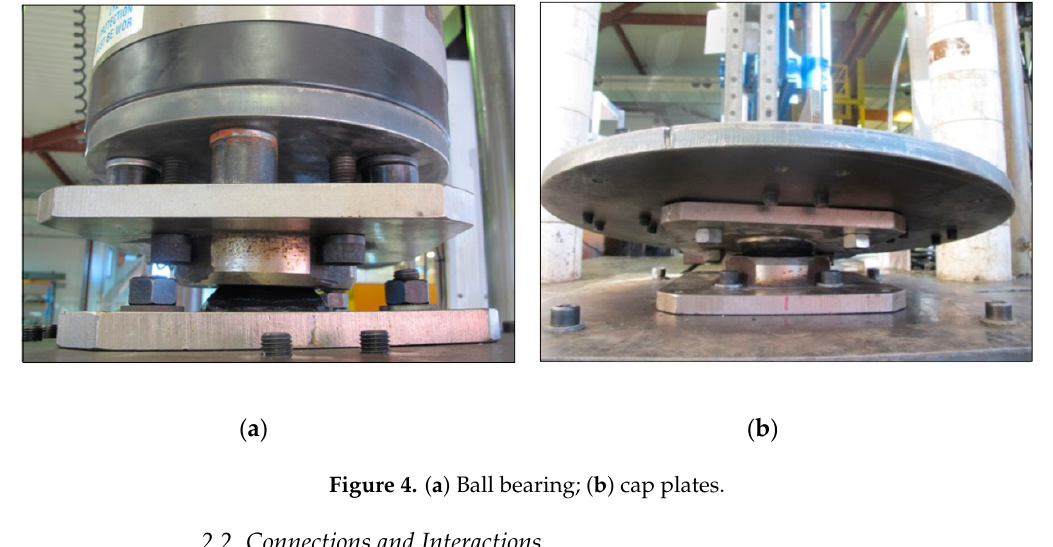
Figure 4. ( a ) Ball bearing; ( b ) cap plates.